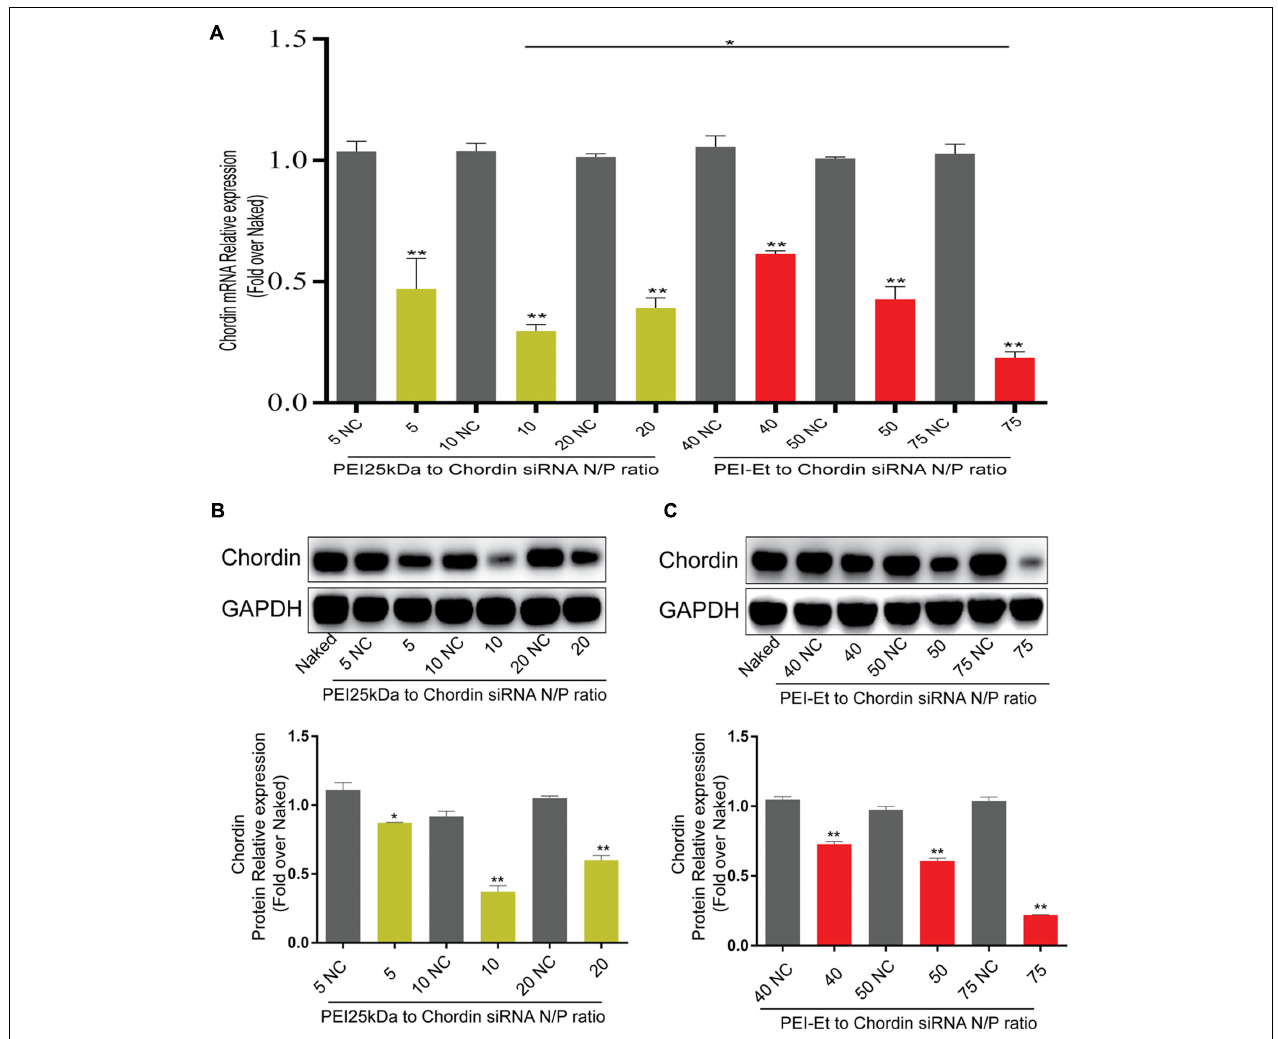
FIGURE 4 | Chordin knockdown by PEI-Et/Chordin-siRNA polyplexes. (A) Chordin mRNA expression measured by real-time PCR after transfection with PEI25kDa/Chordin-siRNA polyplexes and PEI-Et/Chordin-siRNA polyplexes at different N/P ratios. (B) Chordin protein expression measured by Western blot analysis after transfection with PEI25kDa/Chordin-siRNA polyplexes different N/P ratios. Representative images of three repeated experiments were shown. (C) Chordin protein expression measured by Western blot analysis after transfection with PEI-Et/Chordin-siRNA polyplexes different N/P ratios. The Chordin protein level was normalized to GAPDH. Data are represents as means ± SD of three independent experiments. ∗ P < 0.05, ∗∗ P <